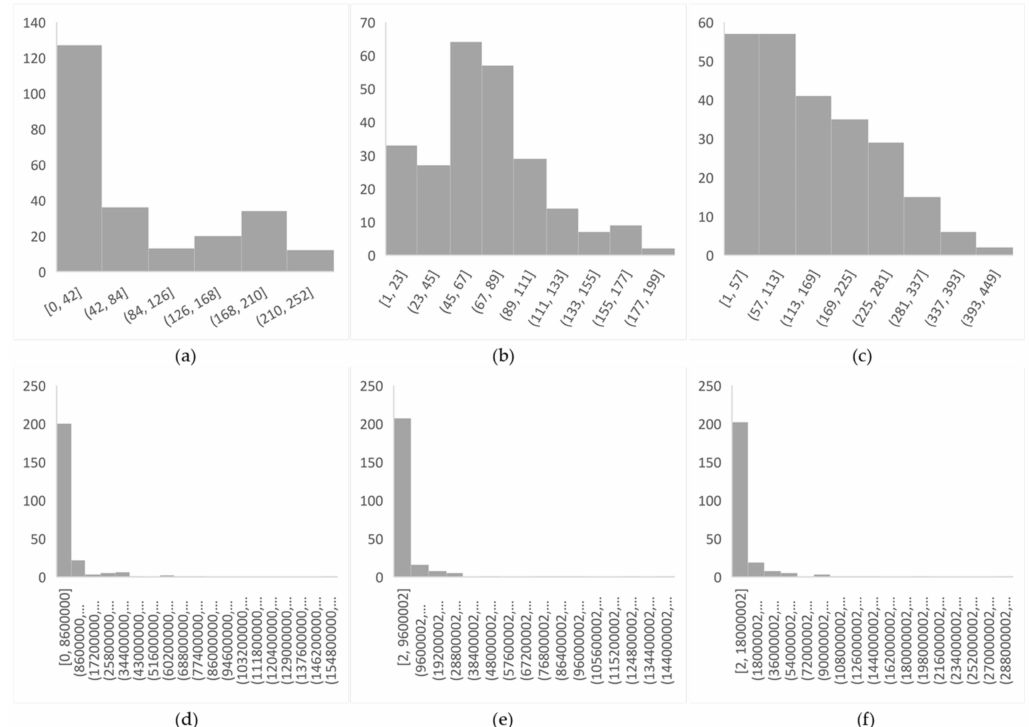
Figure 7. Degree distributions. ( a ) In-degree distribution, ( b ) out-degree distribution; ( c ) degree distribution, ( d ) weighted in-degree distribution, ( e ) weighted out-degree distribution, and ( f ) weighted degree distribution. Source: